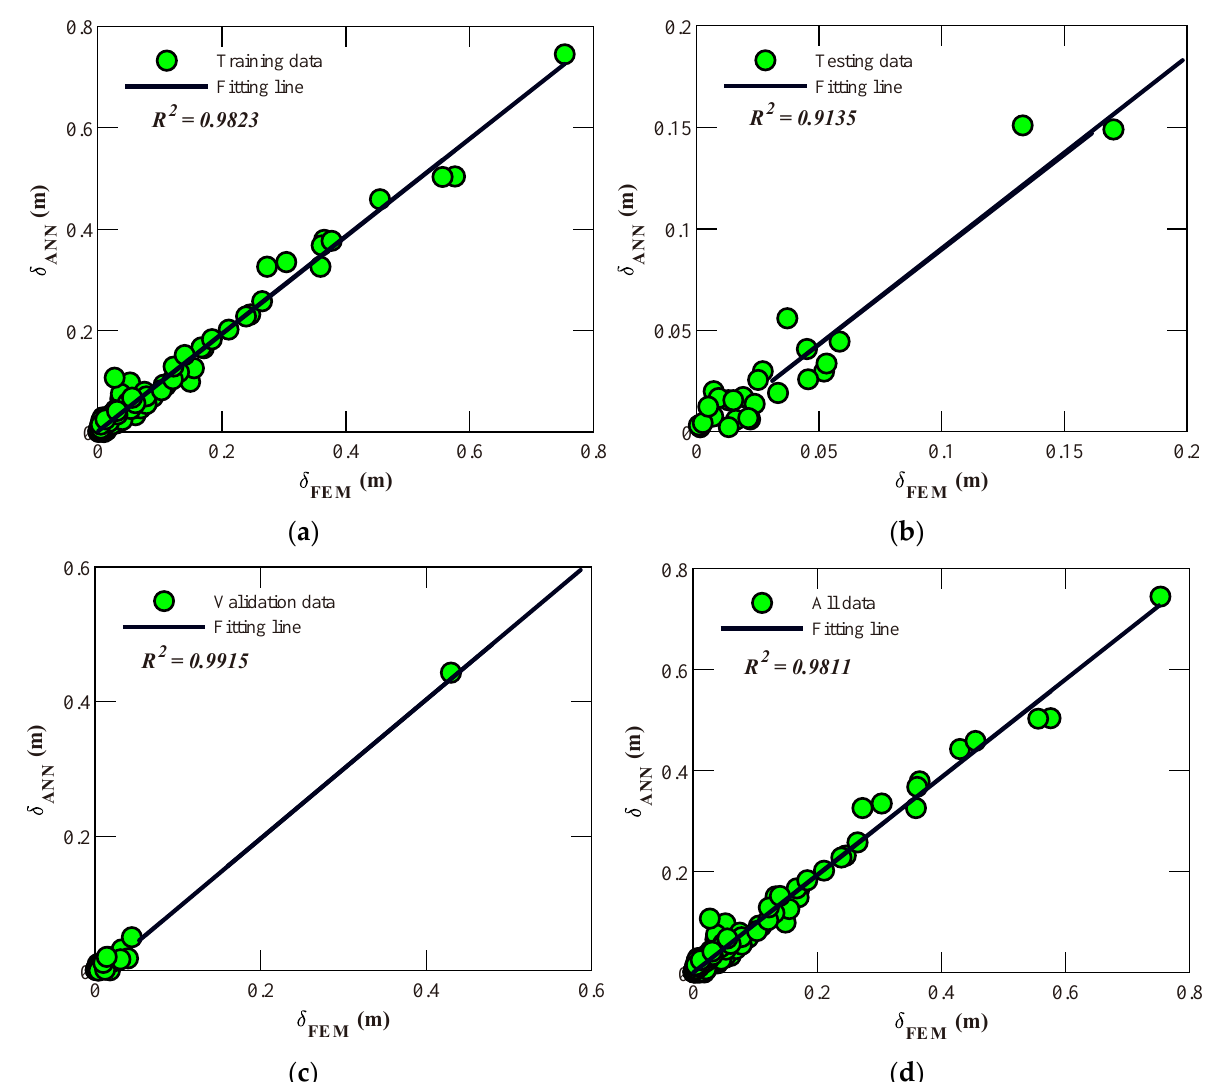
Figure 13. Regression of the developed ANN model: ( a ) training data; ( b ) testing data; ( c ) validation data; ( d ) and all data. Two commonly used performance indicators, root mean square error (RMSE) and mean absolute error (MAE), were selected to evaluate the network performance. The expression